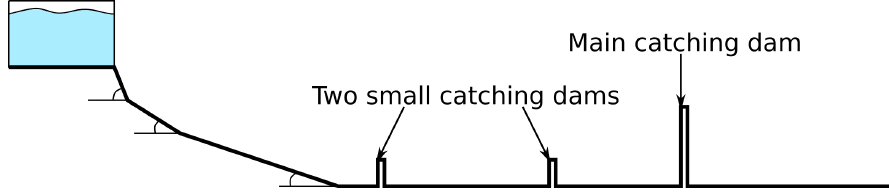
Figure 1. Scheme of chute in University of Iceland